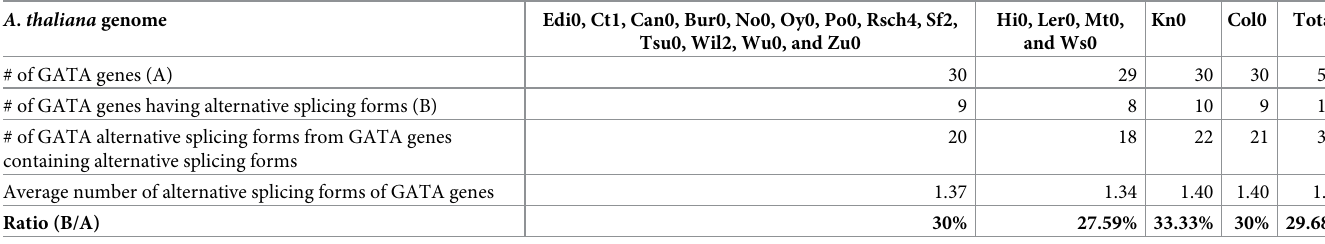
Table 2. Number of GATA genes having alternative splicing forms in 19 A . thaliana genomes. A . thaliana